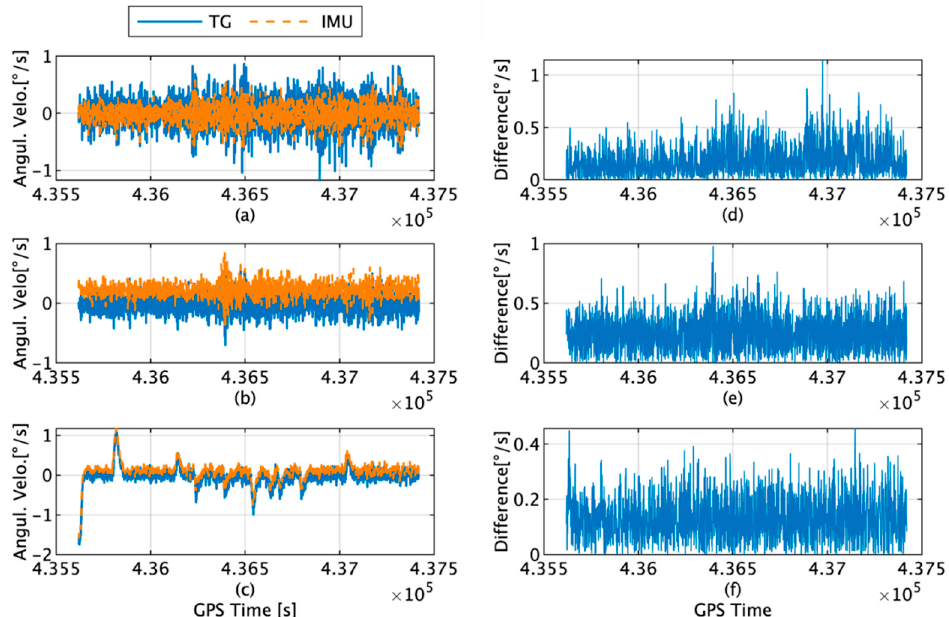
Figure 7. ( a ) Angular velocity along x -axis angular velocity of the IMU (orange) and TG (blue); ( b ) y -axis angular velocity of the IMU (orange) and TG (blue); ( c ) z -axis angular velocity of the IMU (orange) and TG (blue); ( d ) difference in the x -axis angular velocity between the IMU and TG; ( e ) difference in the y -axis angular velocity between the IMU and TG; ( f ) difference in the z -axis angular velocity between the IMU and TG.